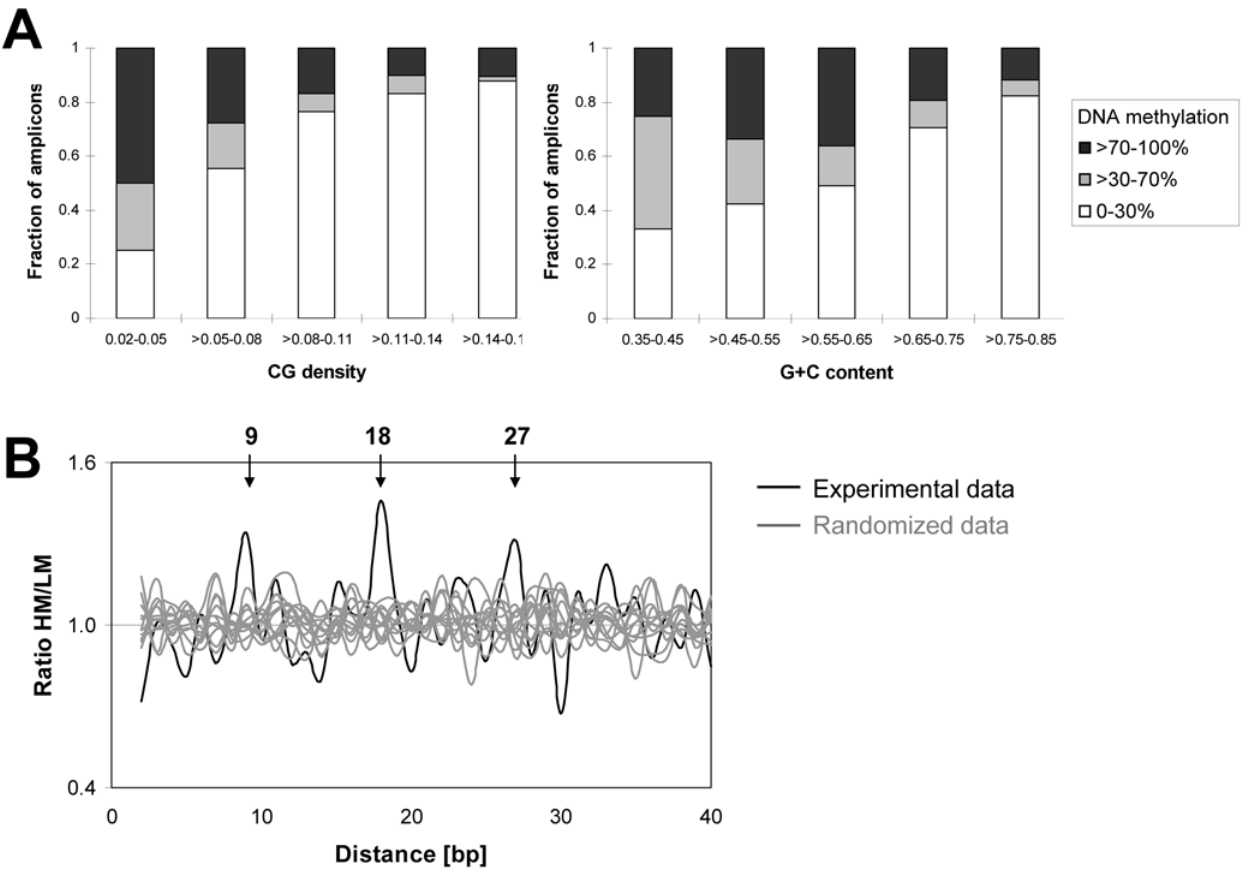
Figure 4. Correlation of DNA methylation and DNA sequence properties. (A) Association of DNA methylation with low CpG density and GC content. (B) Overrepresentation of distances between CpG sites in the sequences of highly methylated DNA as compared to low methylated. The occurrences of all distances of CpG sites were counted in highly methylated (HM) amplicons and low methylated (LM) amplicons. Then, the ratio of both numbers (HM/LM) was plotted versus the distance in bps (shown in black). The same calculation was performed 12 times with randomized methylation level of all amplicons (shown in light gray). The simulations were used to derive the p -value of the overrepresentation of the peaks at 9 bps ( p -value , 2.0 6 10 2 5 ), 18 bps ( p -value , 1.5 6 10 2 8 ) and 27 bps ( p -value , 1.1 6 10 2 4 ).